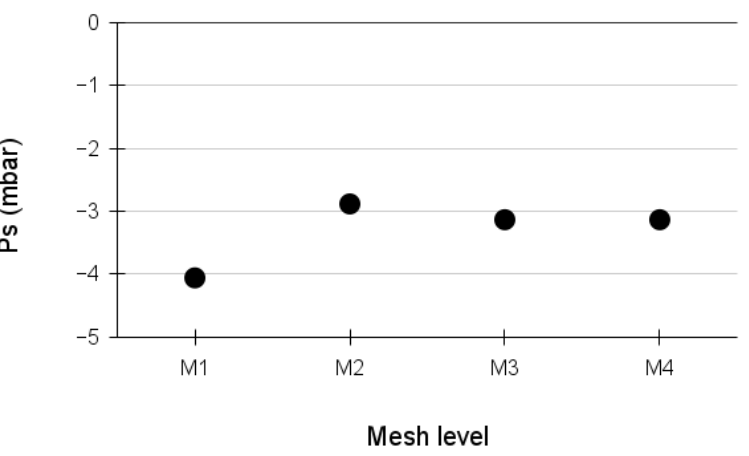
Figure 12. Suction pressure sensitivity to mesh resolution (20,530 rpm, 6 cm chamber base